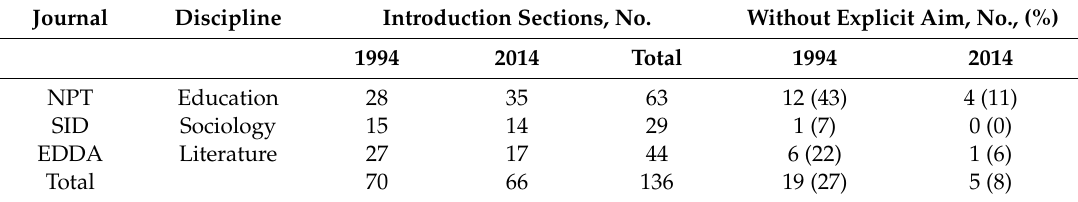
Table 5. Introduction sections without an explicit statement of aim or